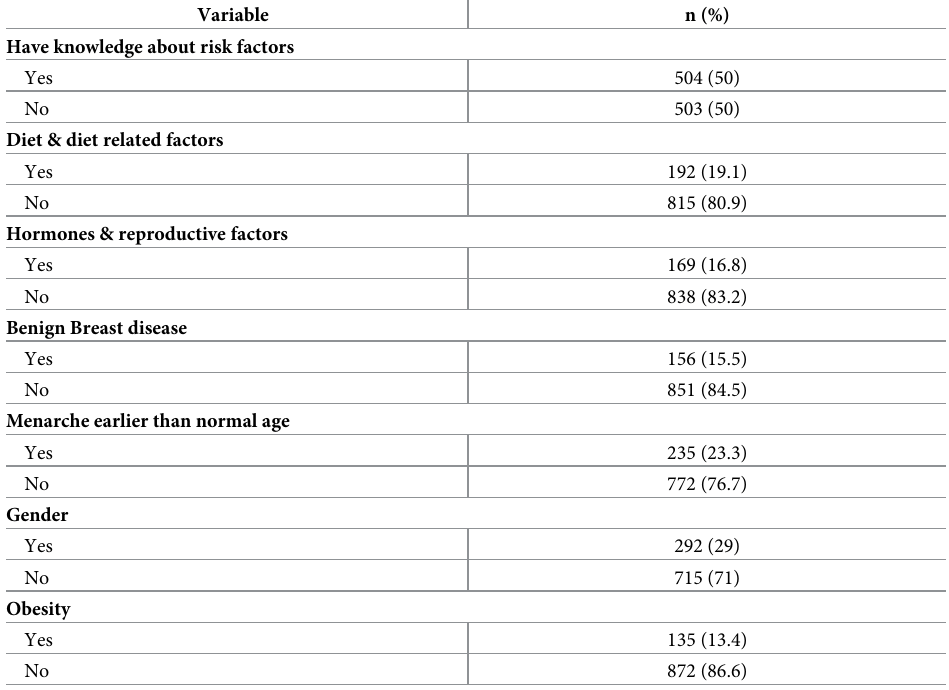
Table 2. Knowledge about risk factors of breast cancer. Variable n